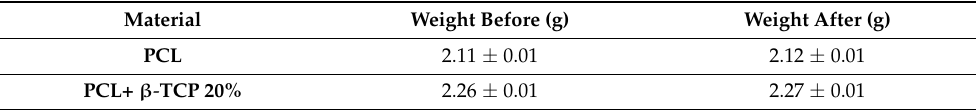
Table 2. Weight evaluation before and after the samples’ immersion in a solution of peracetic acid 2% for 12 min. The means ± the standard deviations were calculated for five samples from each group. No statistically significant differences were observed ( p > 0.05).